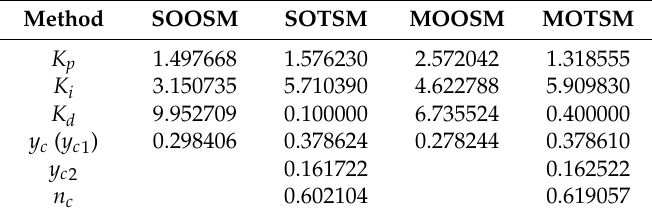
Table 5. Optimization variables obtained by different methods.